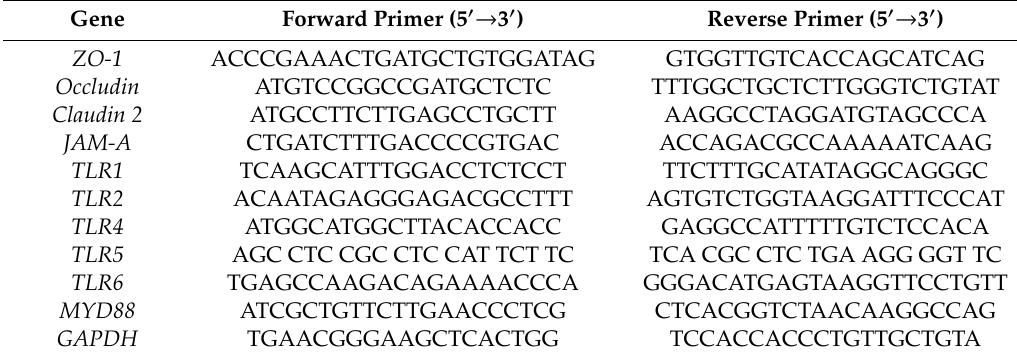
Table 4. Primers used for real-time